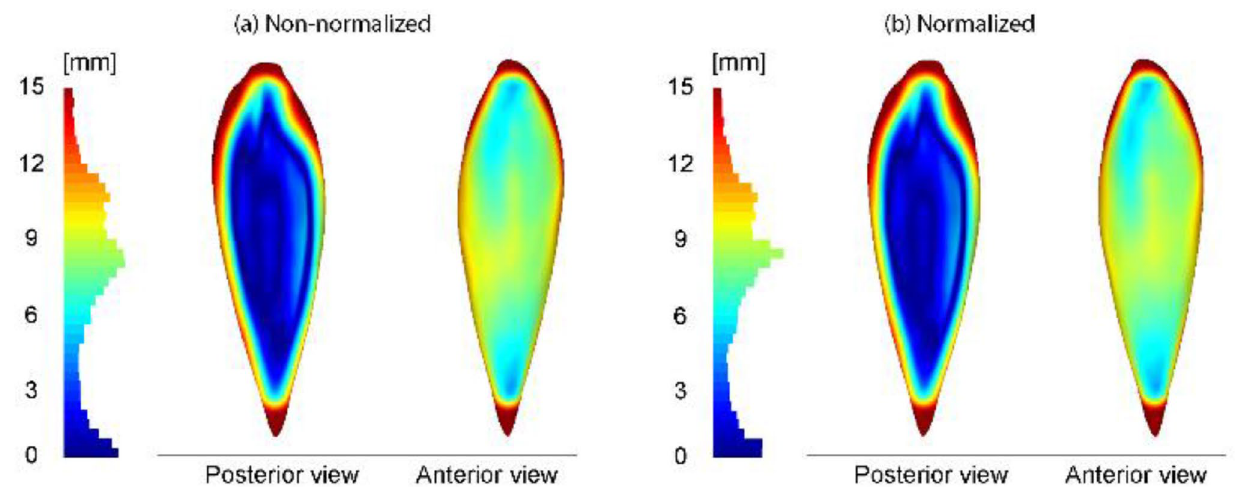
Figure 7. The non-normalized and normalized mean soleus muscles of the TD cohort mapped on the non- normalized and normalized CP-cohort mean soleus muscles. Blue regions indicate a minimal size difference between TD and CP (a TD muscle being similar in size to a CP muscle).; whereas red regions indicate maximal size difference between TD and CP (a TD muscle being greater in size than a CP